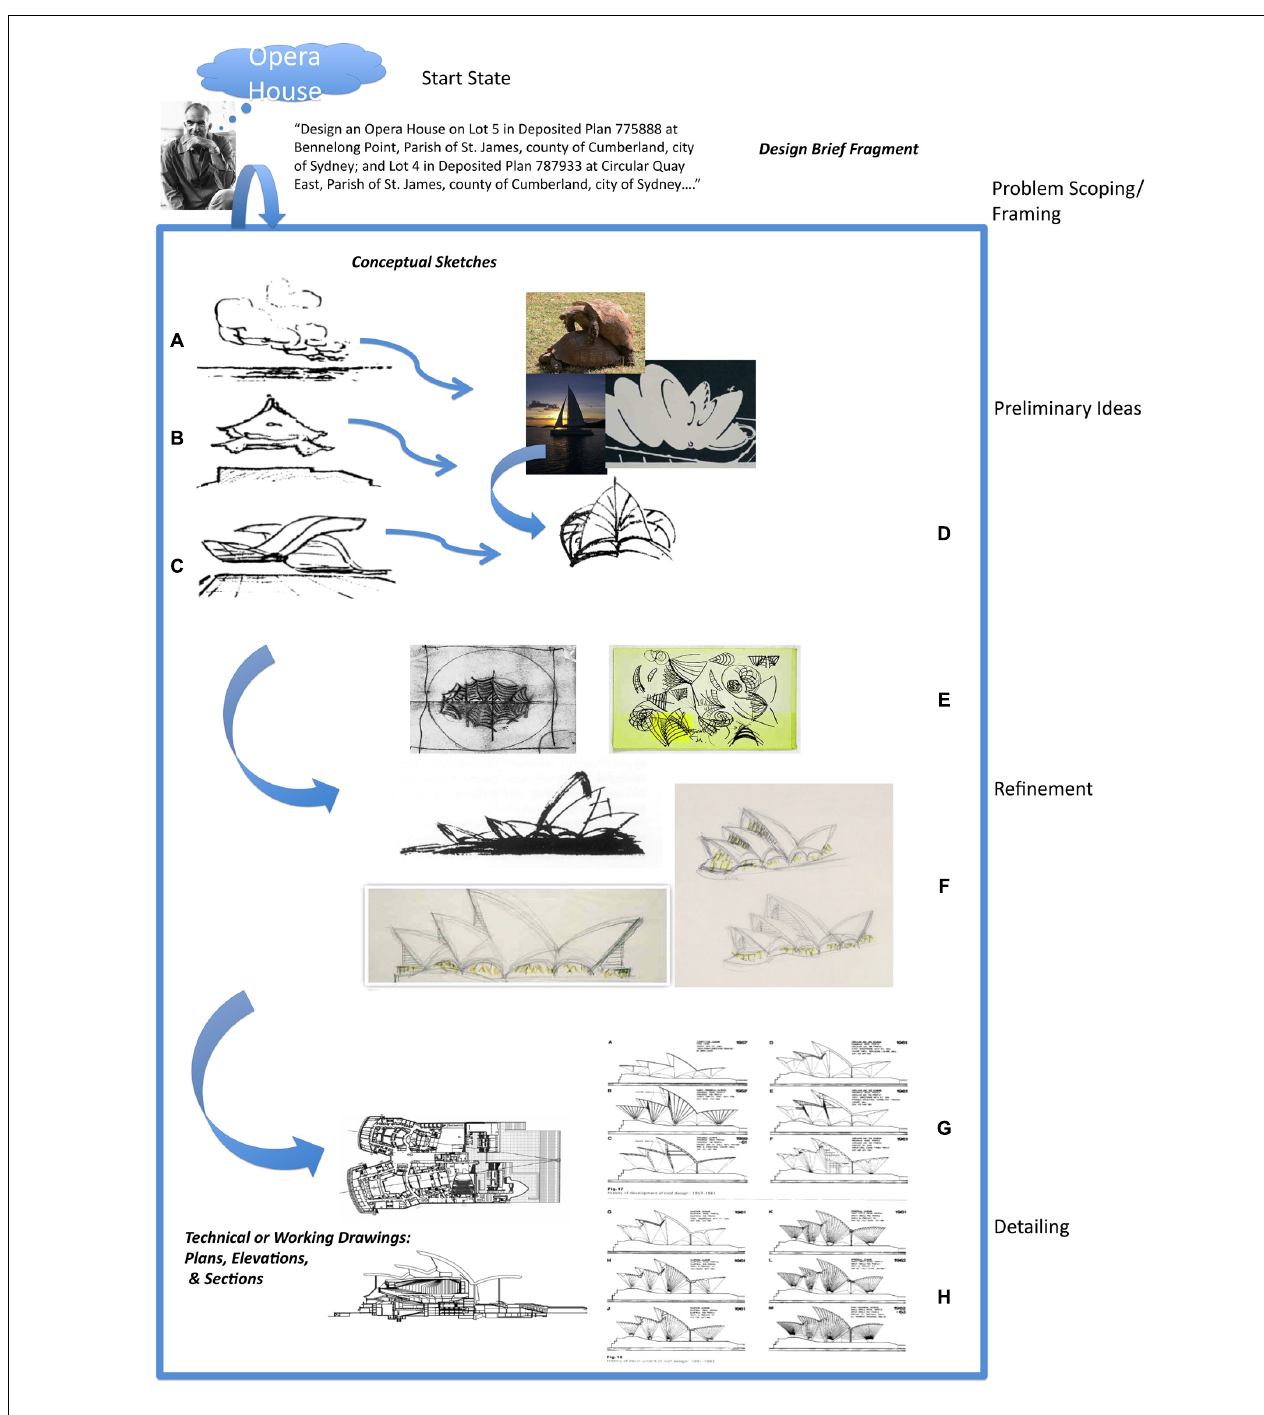
FIGURE 5 |An incomplete and highly speculative reconstruction of Utzon’s problem space. One crucial key to understanding the design problem space is to look at the nature of the several different types of representations utilized by designers. They can be broadly divided up into natural language, conceptual sketches, and contract documents. Design briefs consist largely of natural language sentences. Their level of precision and ambiguity varies. Drawings A – D are examples of early conceptual sketches. There is often no fact of the matter as to what they represent. The “what is that?” is often discovered and emerges after the drawing.